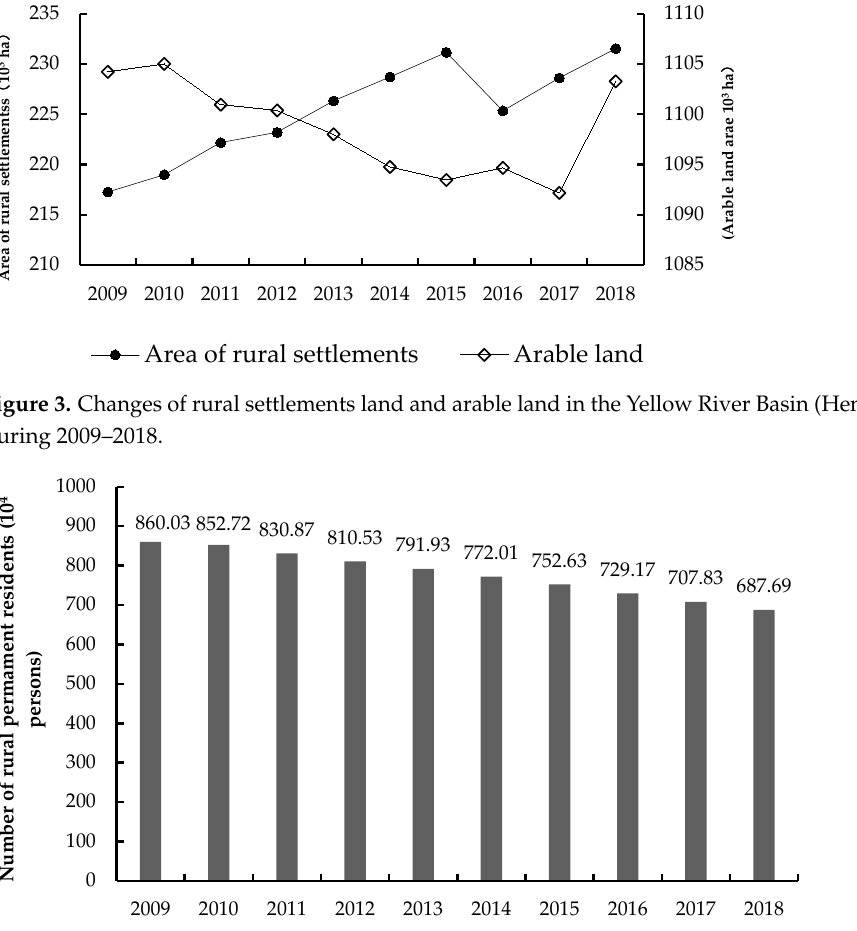
Figure 4. Changes of permanent rural population in the Yellow River Basin (Henan section) during